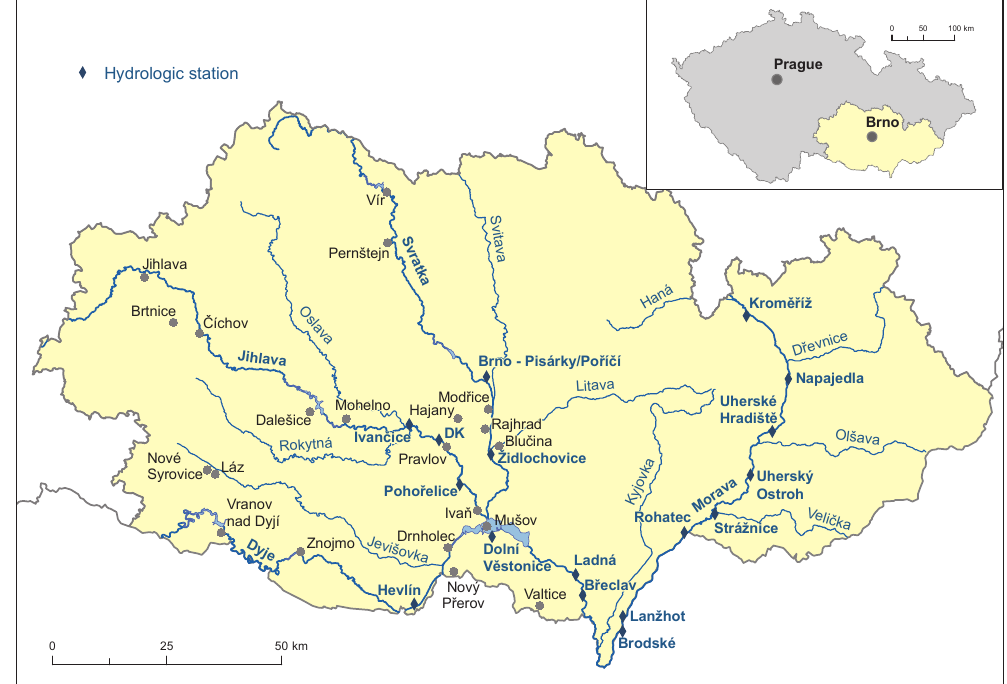
Figure 1. South Moravia with main watercourses, hydrological stations cited and locations mentioned in the text (DK – Dolní